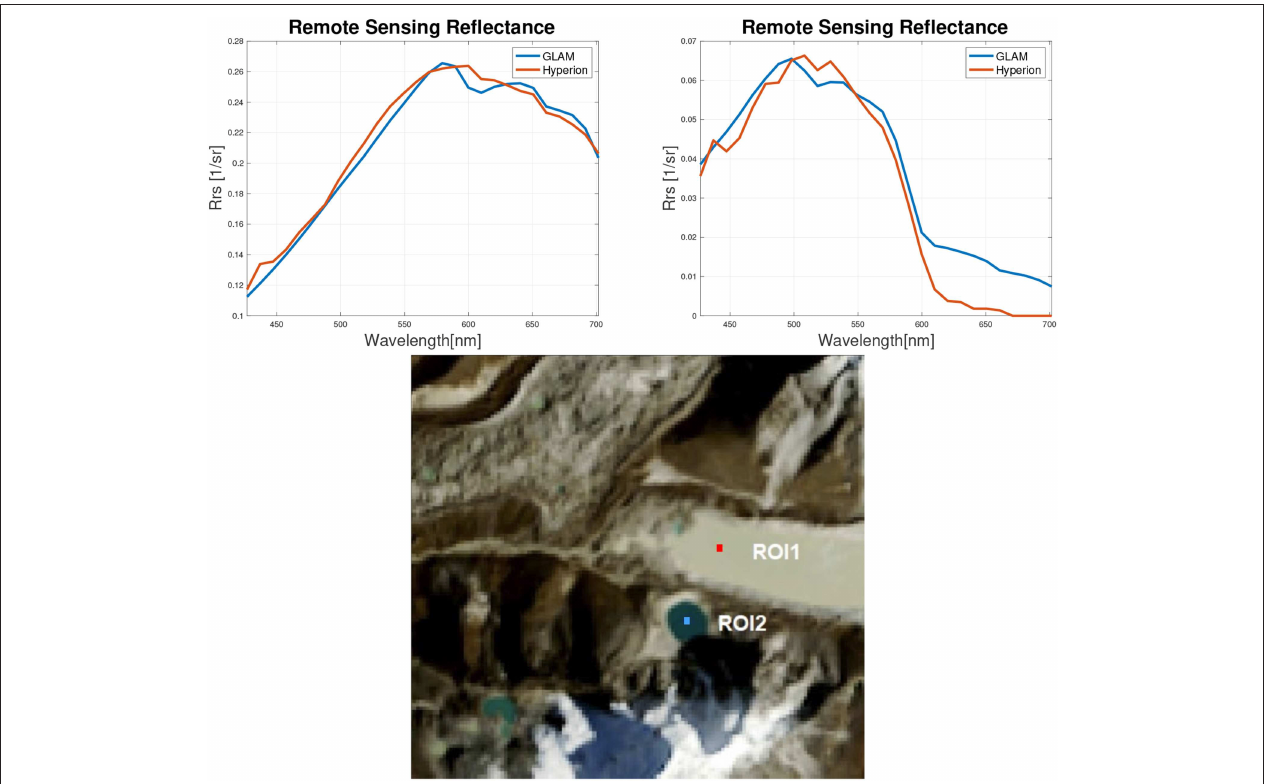
FIGURE 6 | Hyperion reflectances vs. GLAM BioLith–RT simulated reflectances: Imja–ROI 1 (top–left) , Amphulapcha–ROI 2 (top–right) , Hyperion RGB image (bottom) .